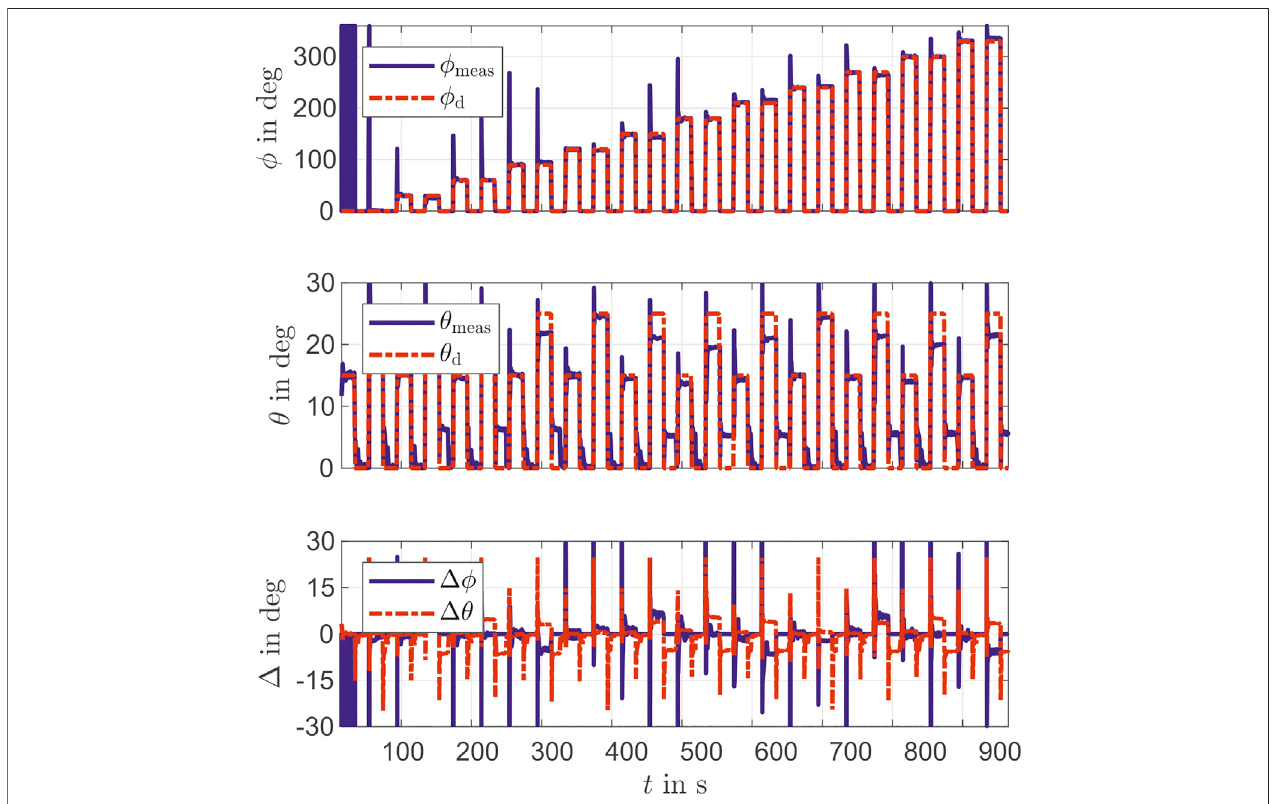
FIGURE 8 | Desired and measured PCC parameters ϕ and θ during validation of PID